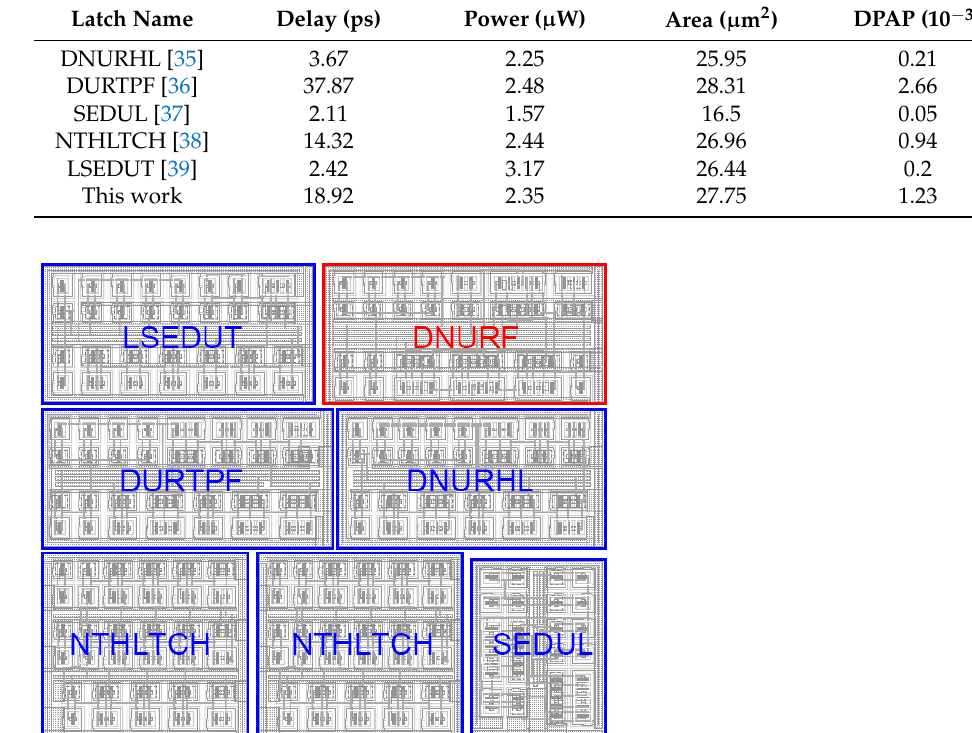
Figure 12. Layout of the proposed DNURF and the other five DNU tolerant latch